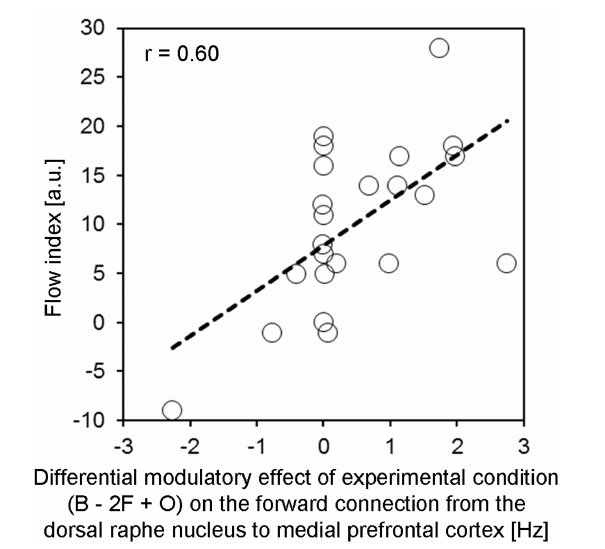
FIGURE 2 | Average parameters (in Hz) over models and participants for family 1 computed by Bayesian Model Averaging after identifying family 1 as the winning family using random effects Bayesian Model Selection. Parameters in black refer to endogenous connection strengths. Direct input and modulatory effects on connections are coded in different colors to represent the experimental conditions boredom (gray), flow (blue), and overload (green). Parameters highlighted in yellow were subjected to repeated measures ANOVAs to test our hypothesis that the dorsal raphe nucleus (DRN) exerted down-regulating influence on activity of the medial prefrontal cortex and/or the amygdala (AMY) in a condition-dependent manner. Whereas the modulatory effects on the medial prefrontal cortex differed significantly between boredom, flow, and overload [ F (2,44) = 4.37, p = 0.019], this was not the case for the AMY [ F (2,44) = 0.16, p = 0.853)]